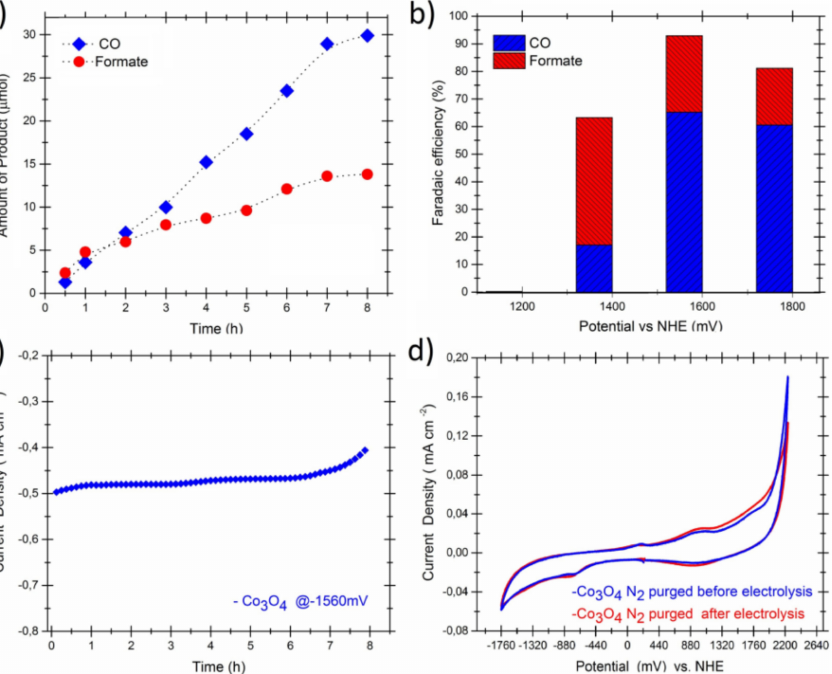
Figure 5. Electroreduction of CO 2 via the nanofibrous Co 3 O 4 , ( a ) increase in the amount of CO gas and formate as a function of time at a regular electrolysis potential of − 1560 mV vs. NHE, ( b ) the electrolysis voltage versus the faradaic efficiency, ( c ) the chronoamperometry results, ( d ) Cyclic voltammograms of the electrode nanofibers measured before and after the electrolysis at a scan rate of 30 mV s − 1 . Reproduced from [131], with permission from Elsevier,